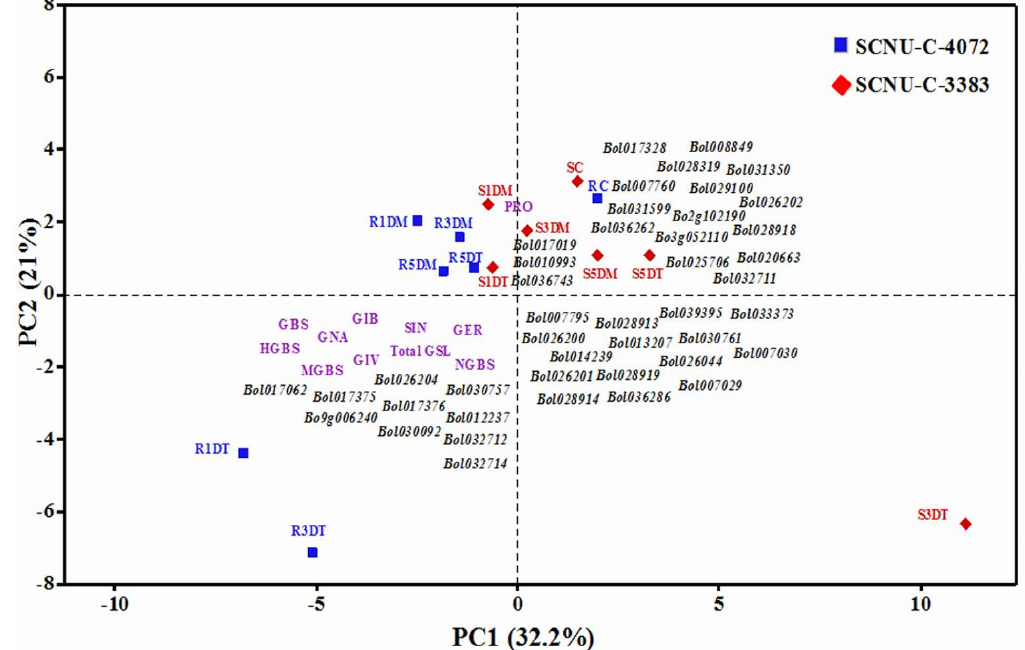
Figure 7. A simple heat map showing correlation between the levels of aliphatic ( A ) and indolic ( B ) glucosinolate components and expression of biosynthesis genes under different treatments (C, control; 1DM, 1 day mock; 1DT, 1 day treated; 3DM, 3 day mock; 3DT, 3 day treated; 5DM, 5 day mock; 5DT, 5 day treated) in the black rot resistant (SCNU-C-4072) and susceptible (SCNU-C-3383) cabbage lines compared to mock-treated samples. Blue colored values represent statistically significant correlations ( p < 0.05 ) for each gene and individual glucosinolate combination, the values indicate the Pearson’s correlation coefficient. Red cells represent positive correlation and green cells represent negative correlation. Yellow cells represent no significant correlation. R, resistant; S, susceptible.